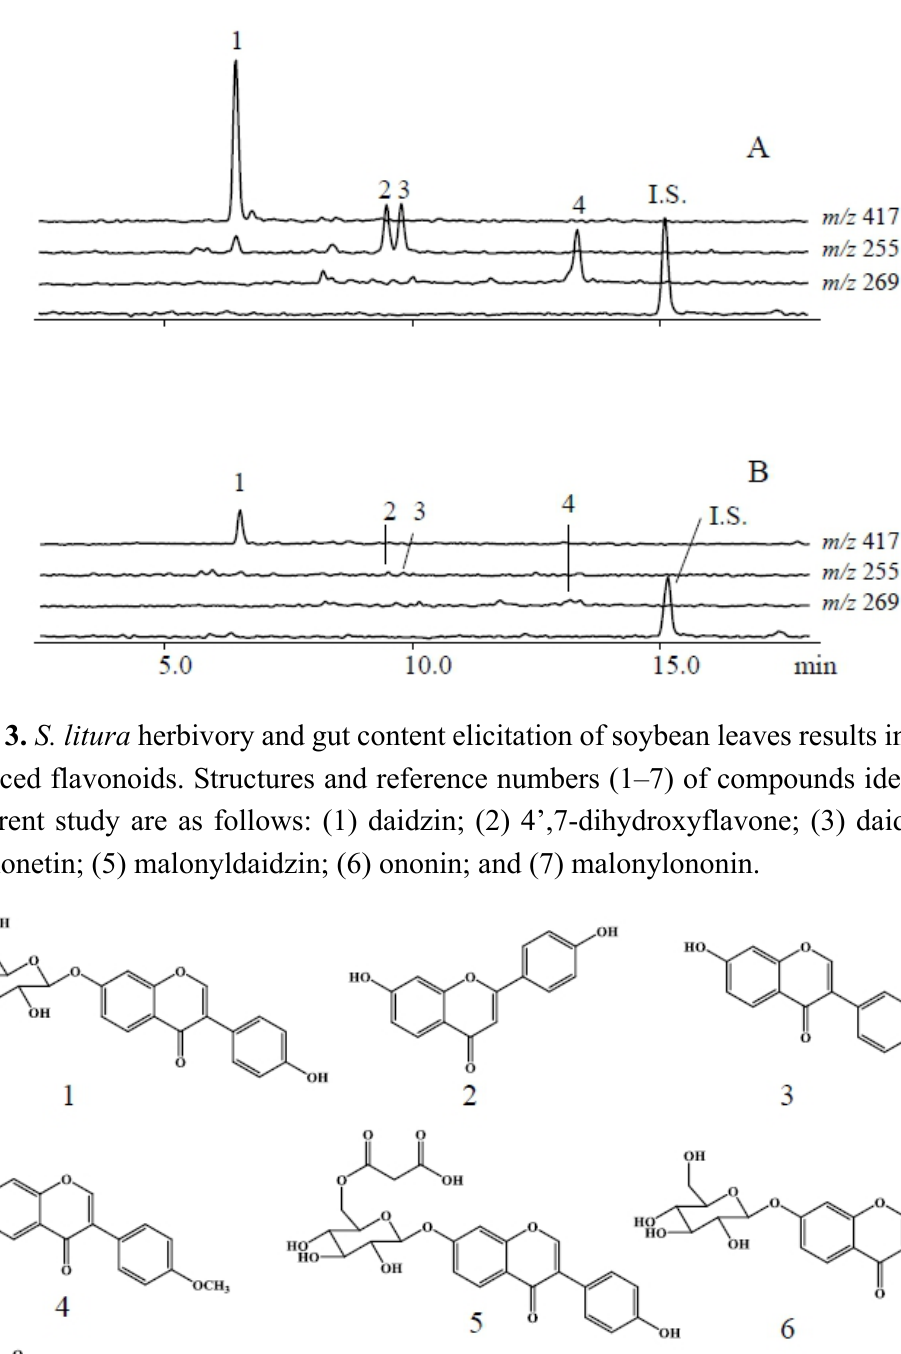
Figure 2. Qualitative analysis of soybean leaf flavonoids that accumulate following S. litura herbivory. LCMS [M+H] + selected ion chromatogram profiles of ( A ) S. litura challenged and ( B ) control leaf extracts. Peak numbers (1–4) correspond to analytes as follows: (1) daidzin ([M+H] + , m/z 417); (2) 4’,7-dihydroxyflavone ([M+H] + , m/z 255); (3) daidzein ([M+H] + , m/z 255); and (4) formononetin ([M+H] + , m/z 269).